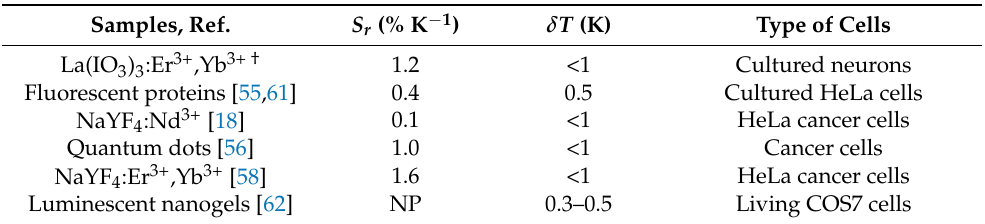
Table 1. Comparison of relative thermal sensitivity ( S r ) and thermal resolution ( δ T ) of different fluorescent thermal sensors used in cells. Samples,